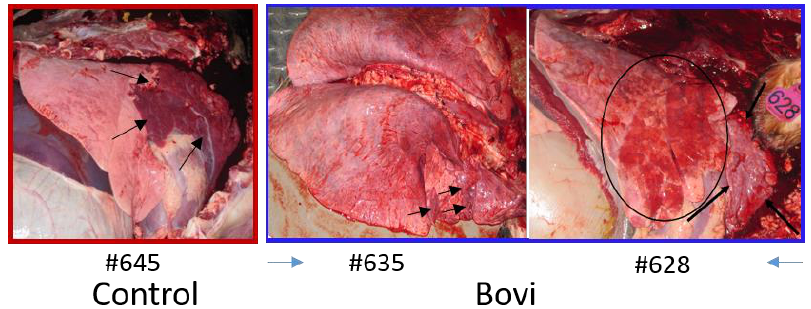
Figure 11. Gross pathology of lung. Lungs from calf # 645 (control group). Cranioventral consolidation of the lungs in the area outlined by arrows. This portion is consolidated with a classical pattern of acute bronchopneumonia. Lungs from calf # 635 (“Bovi” group): Note small areas of reddening and consolidation (arrows) in the cranioventral area of the right middle and cranial lobes. Lungs from calf # 628 (“Bovi” group): Arrows delineate extensively consolidated and fibrotic right cranial lung lobe. The circled area is irregularly reddened. Histologically the latter area had mild, multifocal acute inflammation.